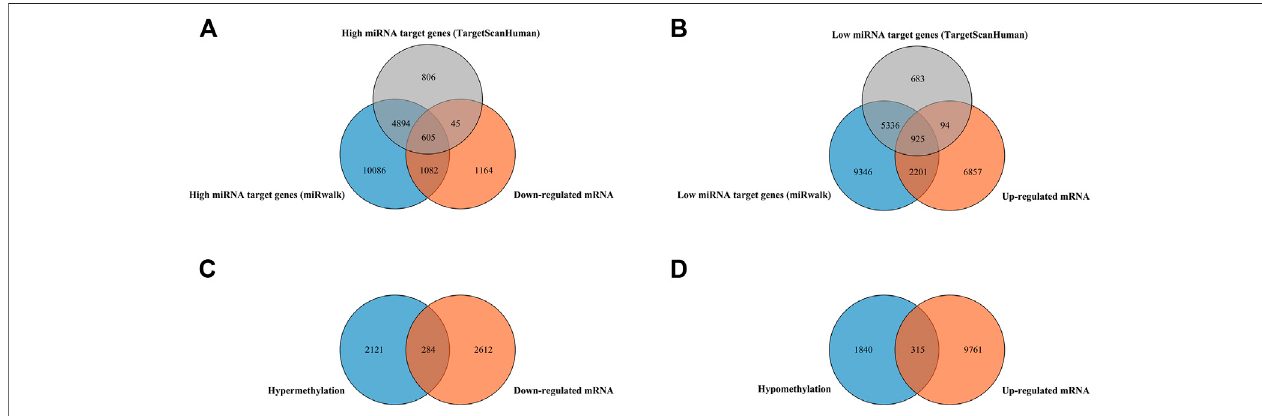
FIGURE 1 | Identi fi cation of target genes of differentially expressed miRNAs and mRNA, as well as aberrantly methylated differentially expressed genes between cancer and adjacent samples from LUAD patients. (A,B) Target genes of differentially expressed miRNAs and mRNAs; miRNA target genes were predicted by microT- CDS online software and the miRWalk database, respectively. (C,D) Aberrantly methylated differentially expressed